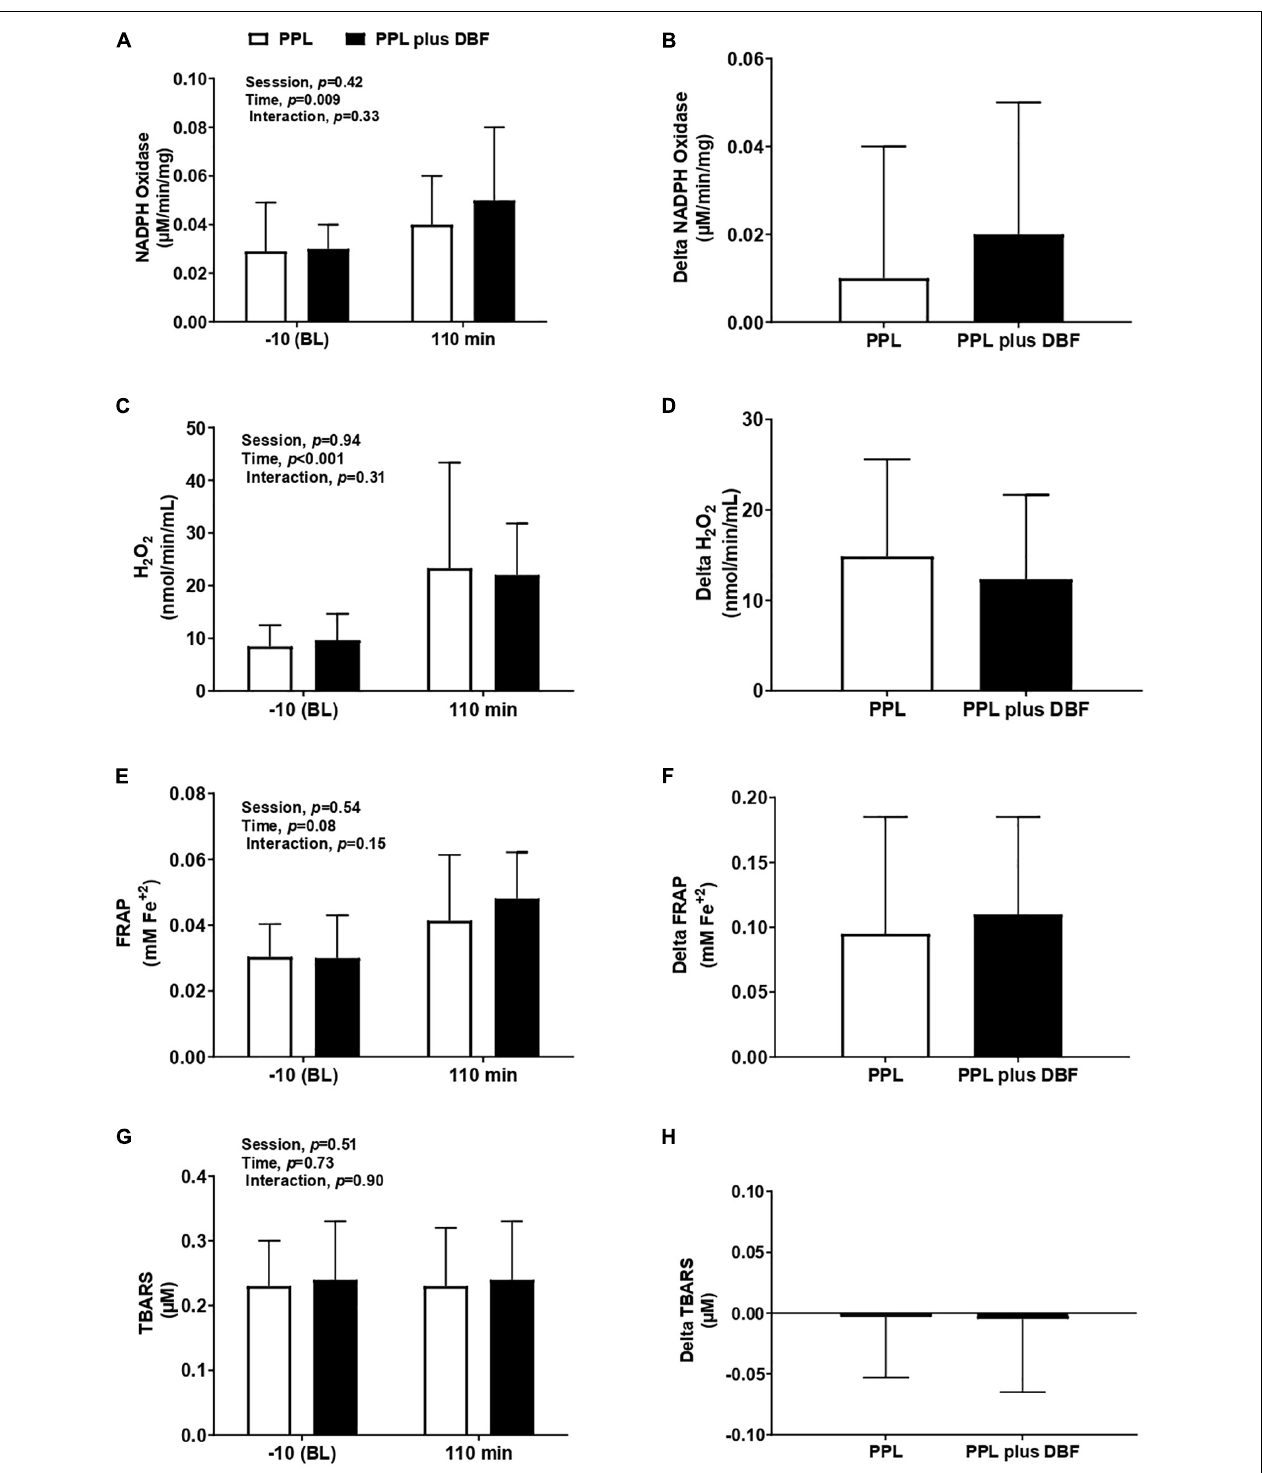
FIGURE 5 | NADPH oxidase (A) , delta NADPH oxidase (B) , H 2 O 2 (C) , delta H 2 O 2 (D) , FRAP (E) , delta FRAP (F) , TBARS (G) , and delta TBARS (H) to postprandial lipemia (PPL) and PPL plus disturbed blood flow (DBF) in healthy individuals. Nicotinamide Adenine Dinucleotide Phosphate Oxidase, NADPH oxidase, H 2 O 2 , hydrogen peroxide; FRAP, ferric reducing/antioxidant power; TBARS, thiobarbituric acid reactive substances. Data presented as mean ± standard deviation. Absolute delta was calculated as 110 min variable – baseline variable.